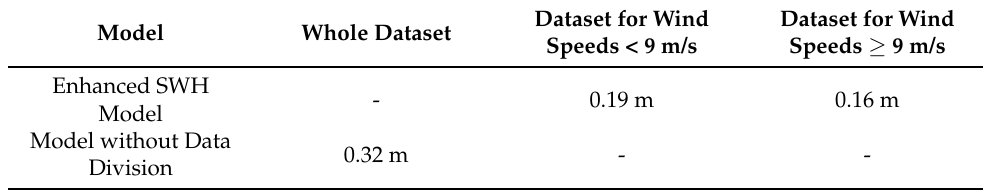
Figure 15. Retrieved SWHs by enhanced model with wind speed divided into wind speeds < 9 m/s (blue color) and wind speeds ≥ 9 m/s (red color) regions.The black line is ‘y = x’ for reference. Table 2. RMSE of the retrieved